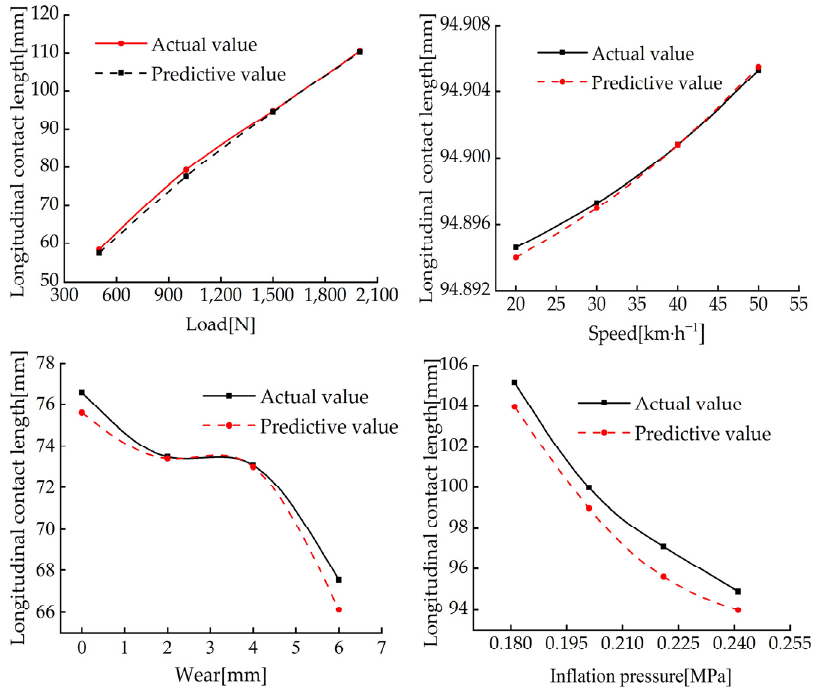
Figure 28. Verification results of the longitudinal estimation of the tire contact patch length.